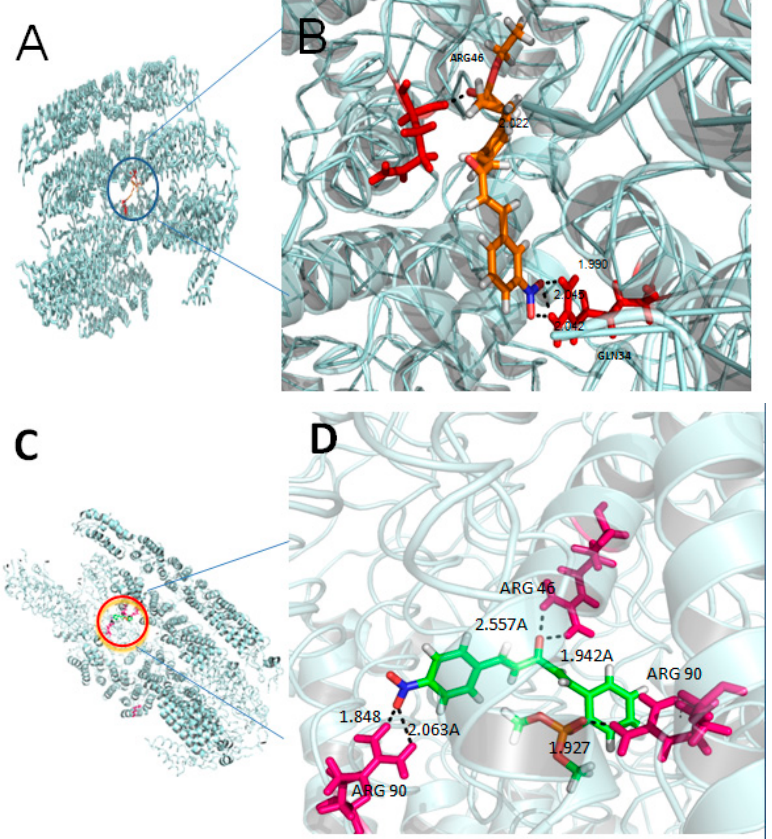
Figure 4. Molecular docking studies of compounds 3h ( A , B ) and 3j ( C , D ).